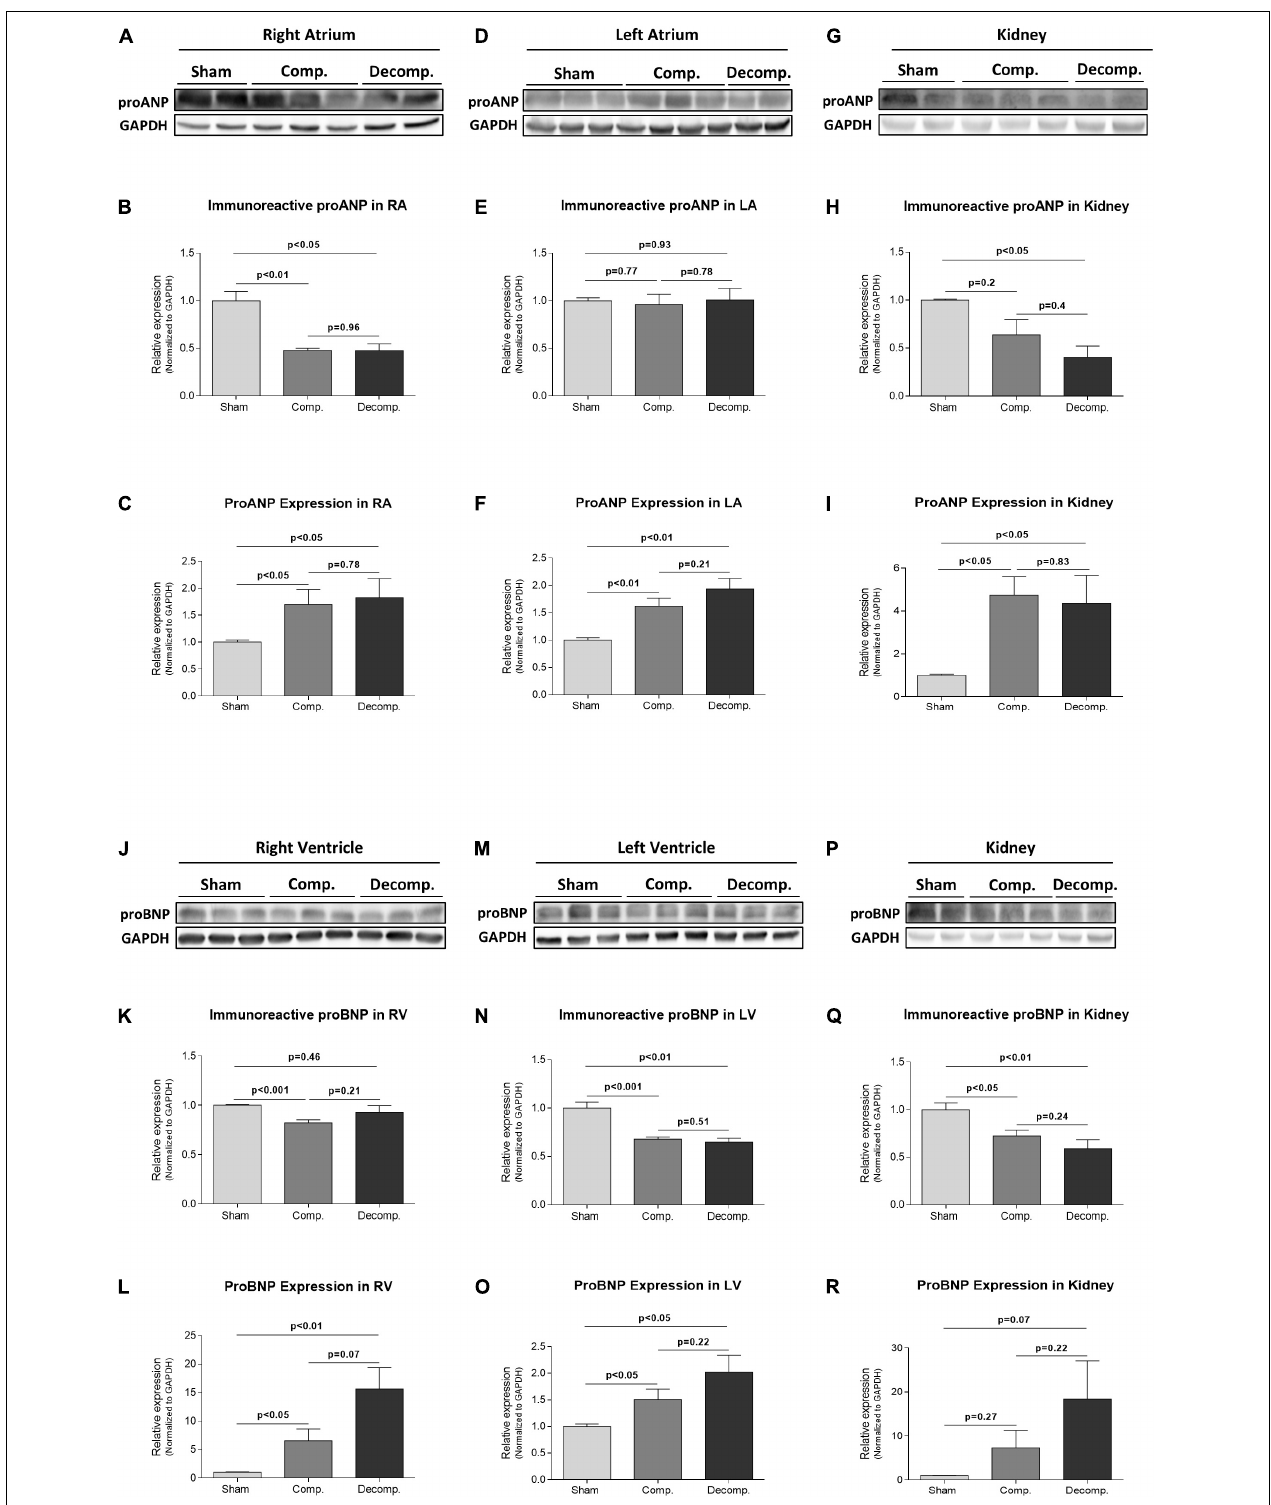
FIGURE 7 | Abundance and expression of atrial and B-type natriuretic peptides in the cardiac and renal tissues of ACF and sham-operated rats. Representative western blot analysis of proANP (A,D,G) and proBNP (J,M,P) and their quantification relative to GAPDH (B,E,H,K,N,Q) in heart chambers and kidneys of ACF and sham-operated rats. (C F,I,L,O,R) Represent quantification of qPCR analysis of proANP and proBNP mRNA relative to GAPDH in the same tissues. Values are presented as means ± SEM.